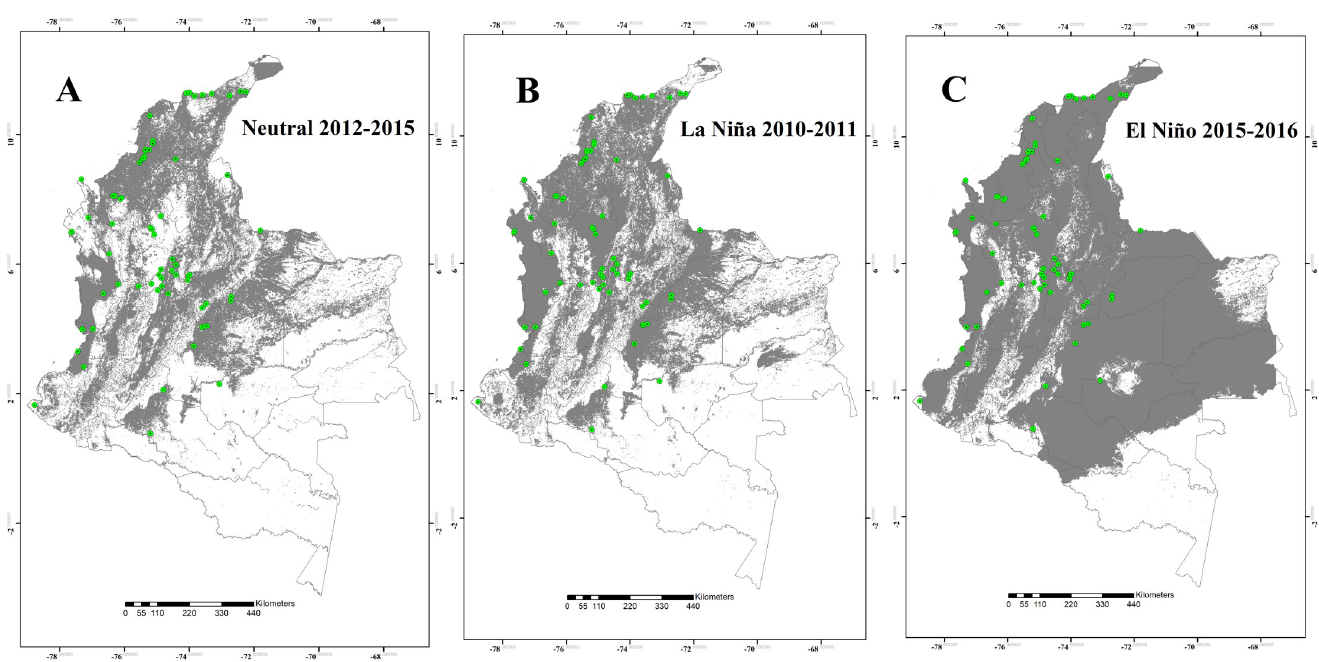
Fig 3. Potential distribution maps for Lutzomyia gomezi . (A) Neutral 2012–2015 episode. (B) La Ni ñ a 2010–2011 episode. (C) El Ni ñ o 2015–2016 episode. Models were calibrated across the hypothesized area of dispersion (M) and transferred across all Colombia. Green points are occurrences, gray areas are modeled suitable conditions, and white areas are unsuitable conditions. Points correspond to data in S1 Appendix, and maps were done using Maxent and ArcGIS software.